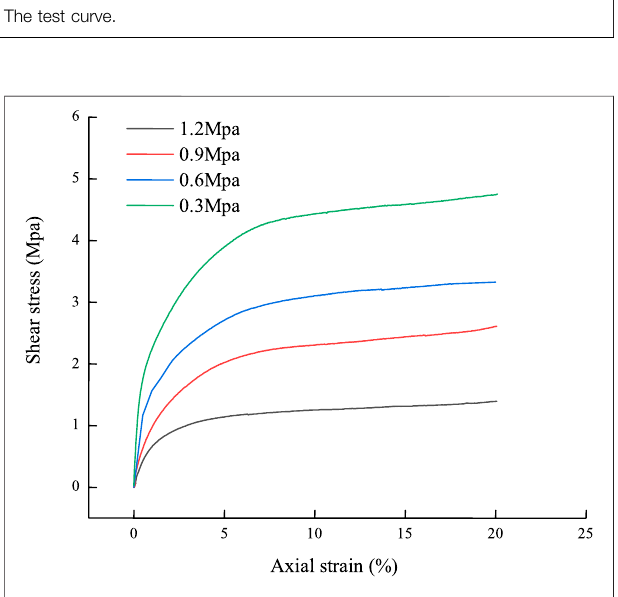
FIGURE 5 | Results of unconsolidated and undrained shear triaxial test of whole stone slag diagram.